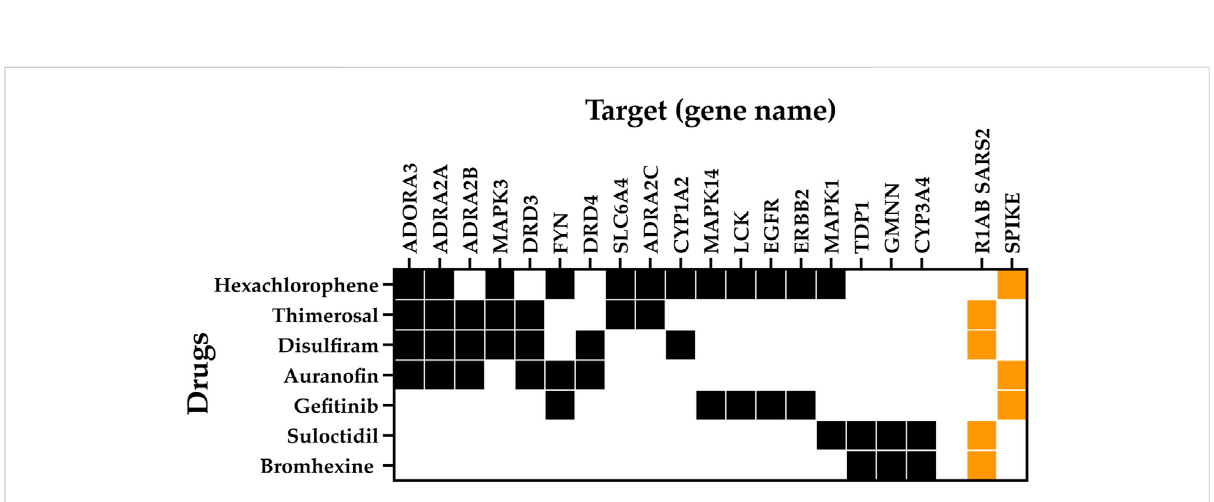
FIGURE 4 Multitarget interaction pro fi le of the potential antiviral drug. Diagram summarizing drug interactions to key human proteins (black) and viral proteins